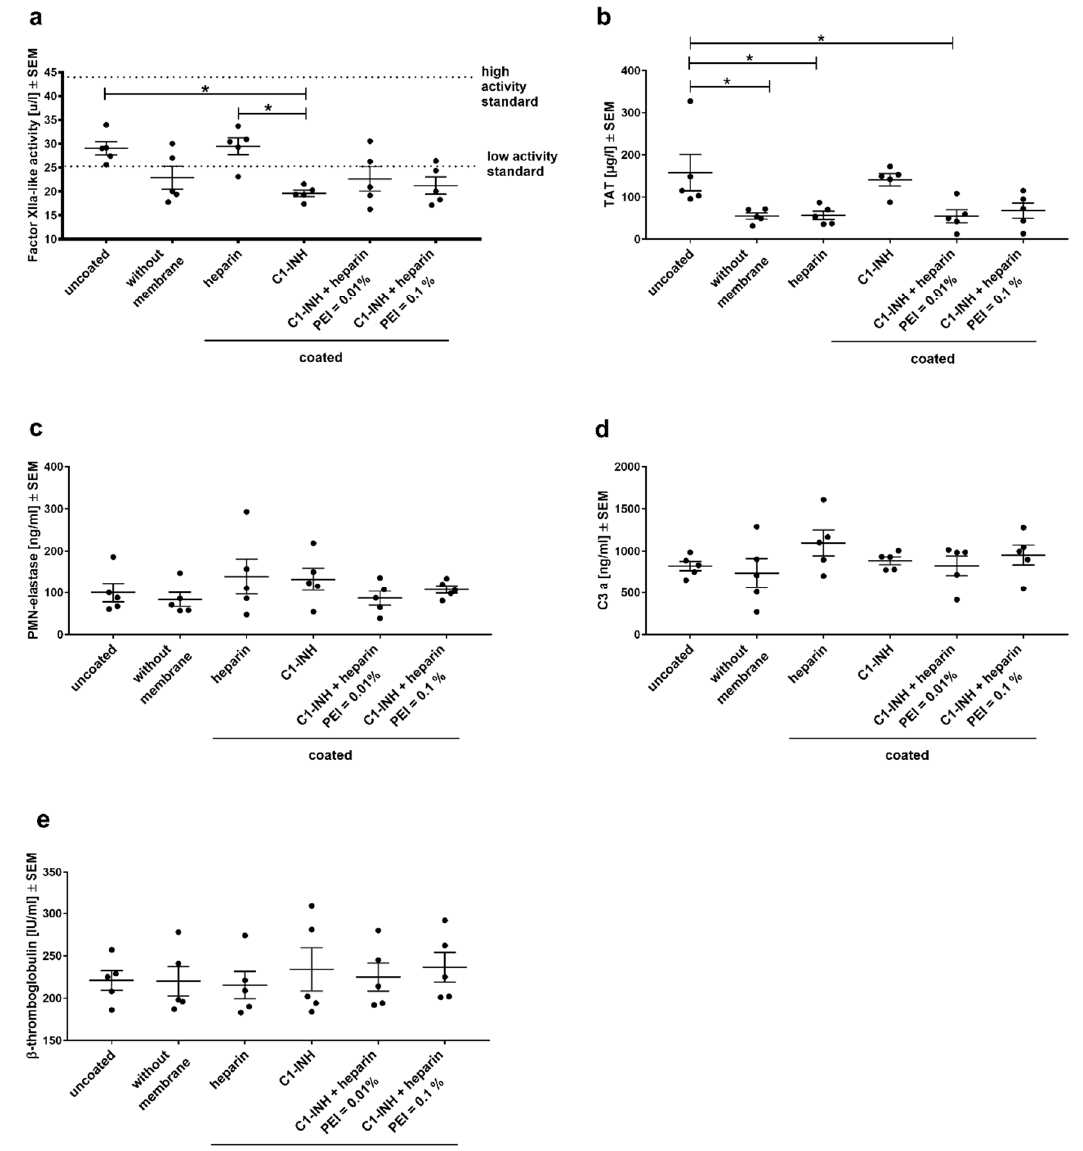
Figure 5. C1-INH coating prevented FXII activation, while heparin coating prevented TAT formation. Hemocompatibility analysis of differently coated PMP membranes: blood markers for the contact phase system (FXIIA-like activity) ( a ), coagulation (TAT) ( b ), activation of neutrophils (PMN-elastase) ( c ), complement system (C3a) ( d ), and platelet activation ( β -thromboglobulin) ( e ). Statistical analysis was performed using one-way ANOVA with Bonferroni’s multiple comparison post hoc test. The mean value of each column was compared with the mean value of each other column. n = 5; * p < 0.05.